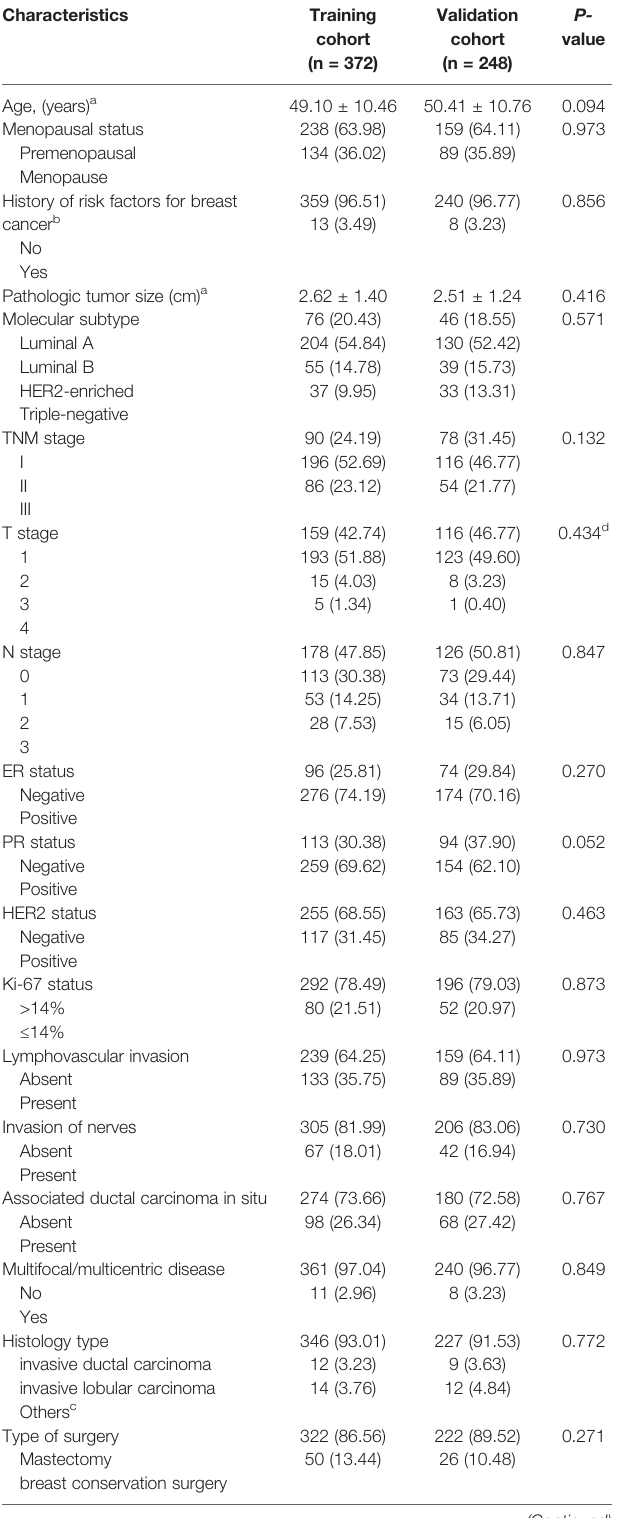
TABLE 1 | Characteristics of patients in the training and validation